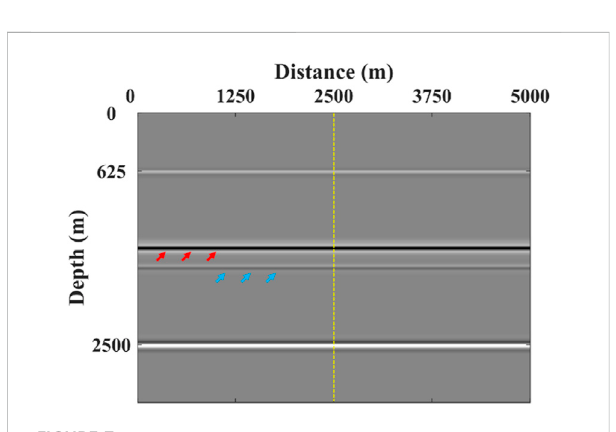
FIGURE 7 The migration result using primaries and multiples. The light blue arrows and the red arrows indicate causal crosstalk and anti-causal crosstalk,